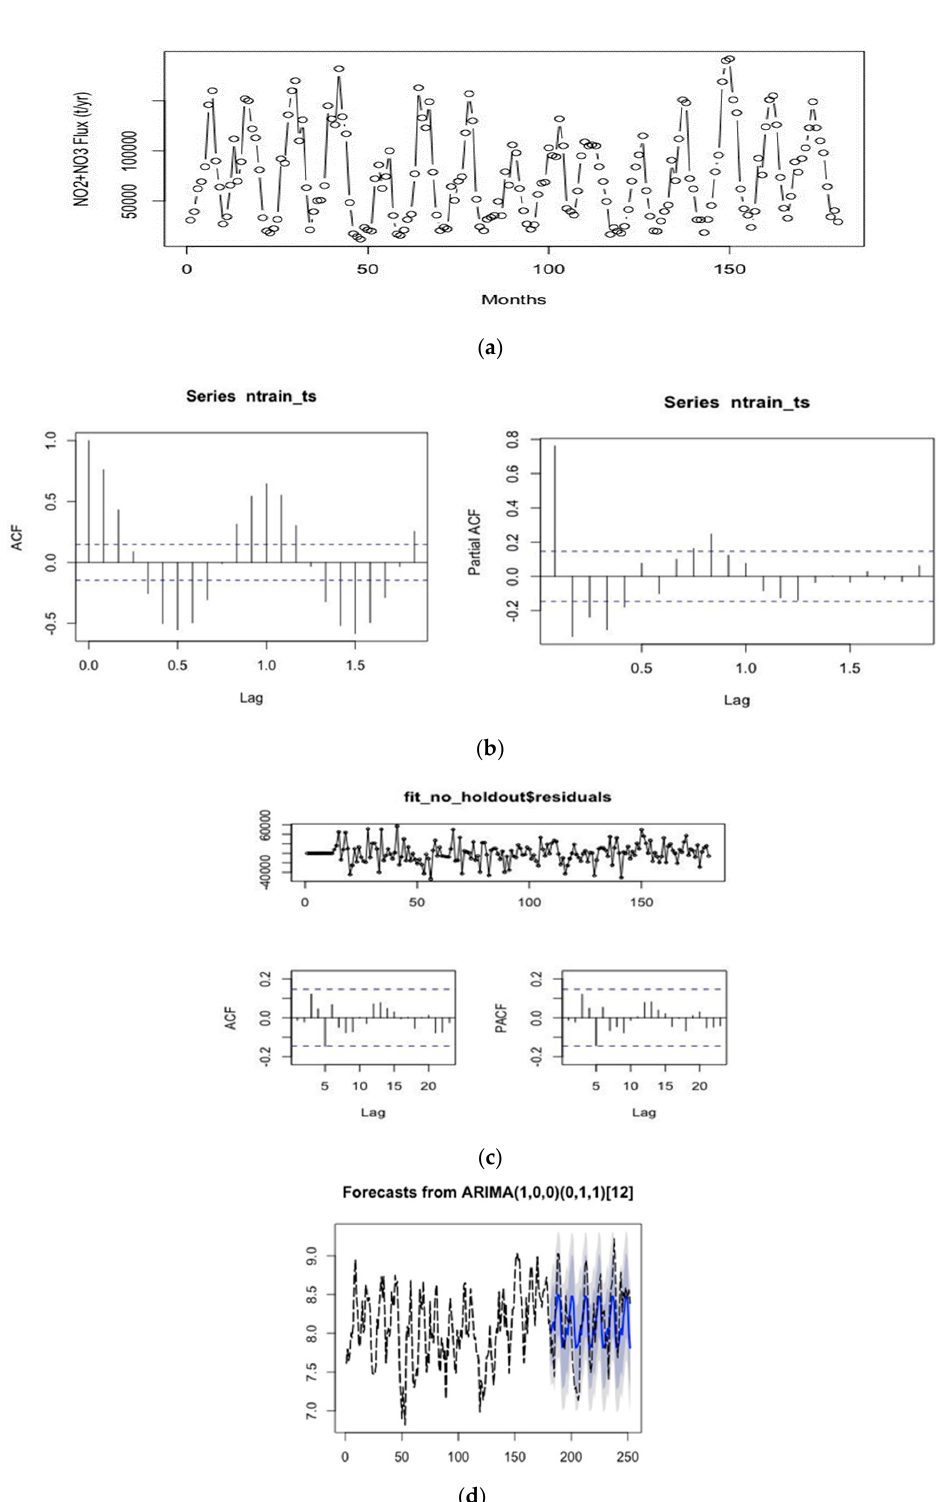
Figure 7. Results of the autoregression integrated moving average (ARIMA) analysis of orthophosphate data. ( a ) Monthly observations of orthophosphate concentration expressed on a linear scale and logarithmic transformation; ( b ) ACF and PACF plots of the training data; ( c ) the residuals plot of ARIMA (1,0,0) × (0,1,1) 12 ; and ( d ) mean monthly forecasts of orthophosphate load from October 2010 through September 2016 on a logarithmic scale (the blue line is a predictive line). The ACF and PACF of logarithm-transformed data were computed and shown in Figure 7. In